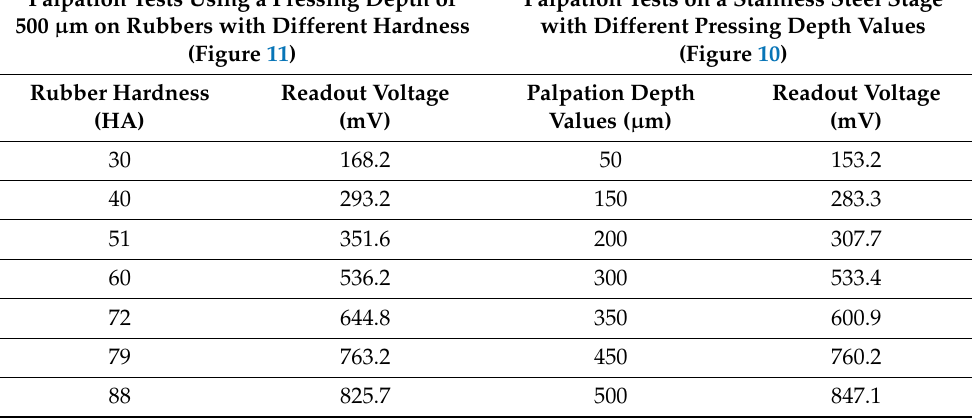
Table 3. Comparison of the readout voltage values in Figures 10 and 11 with the minimum difference. Palpation Tests on a Stainless Steel Palpation Tests Using a Pressing Depth of 500 µ m on Rubbers with Different Hardness (Figure 11)